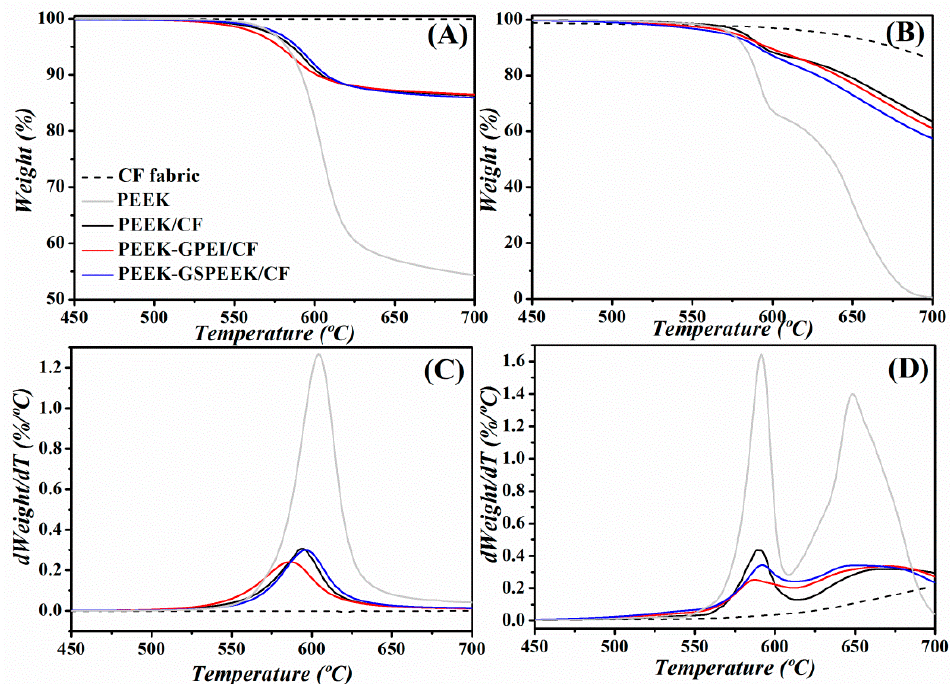
Figure 4. Thermogravimetric and first derivative thermogravimetric curves for the three laminates investigated, the CF fabric and neat PEEK, obtained under nitrogen ( A , C ) and air ( B , D ) atmospheres. The colour code in ( A ) applies to all data.